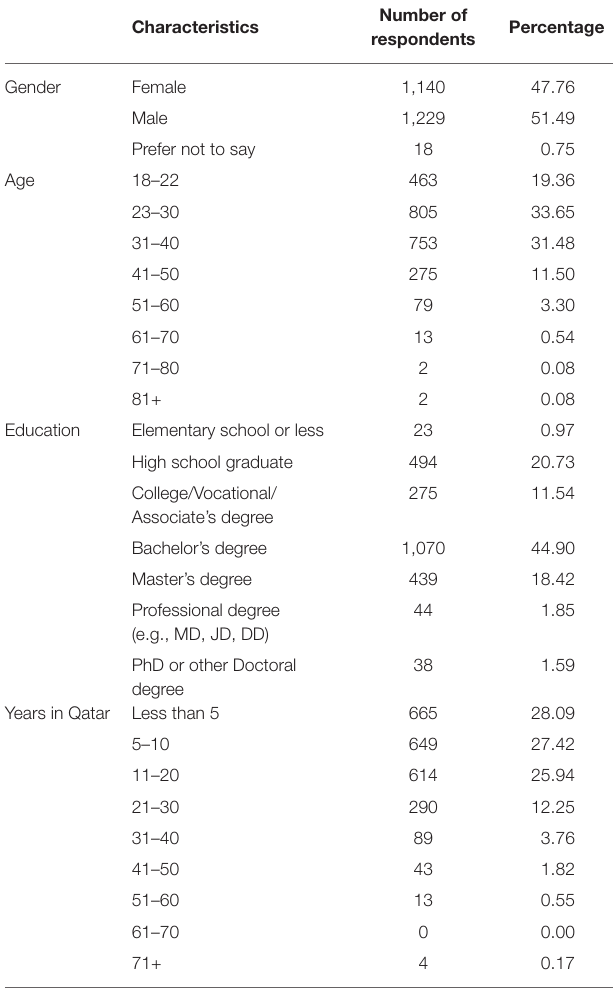
TABLE 1 | Descriptive statistics for demographic